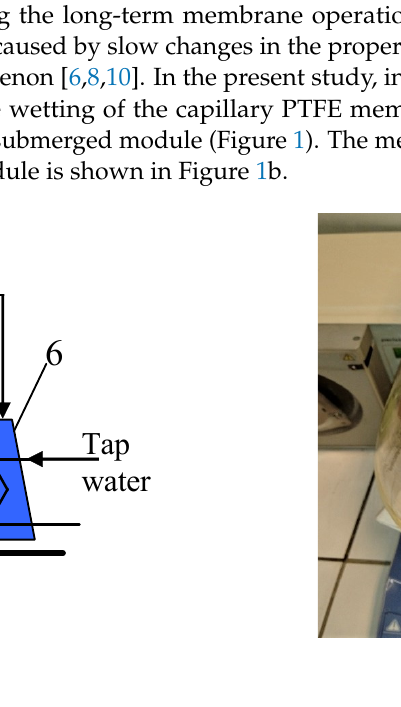
Figure 1. Experimental MD setup. ( a ) Installation scheme: 1—submerged module; 2—feed tank; 3—magnetic stirrer with heating plate; 4—balance; 5—peristaltic pump; 6—distillate tank; T—thermometer. ( b ) Submerged module connected with the distillate line.